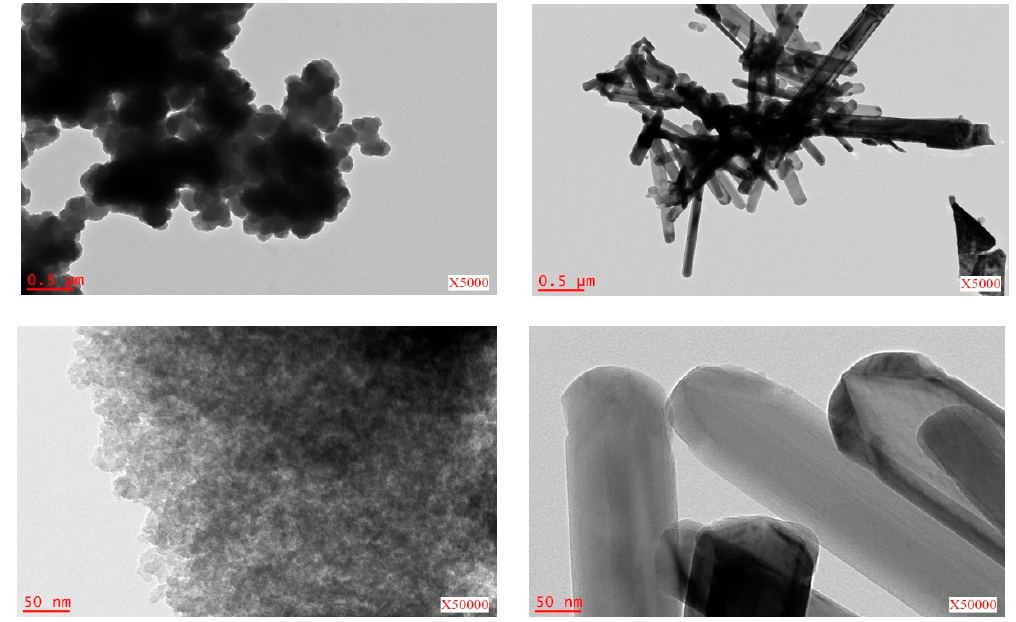
Figure 1. Materials produced by hydrothermal carbonisation (HTC) of VOSO 4 ·5H 2 O–Mimosa tannin solution at different magnifications: before ( left ) and after ( right ) calcination in air; TEM pictures.